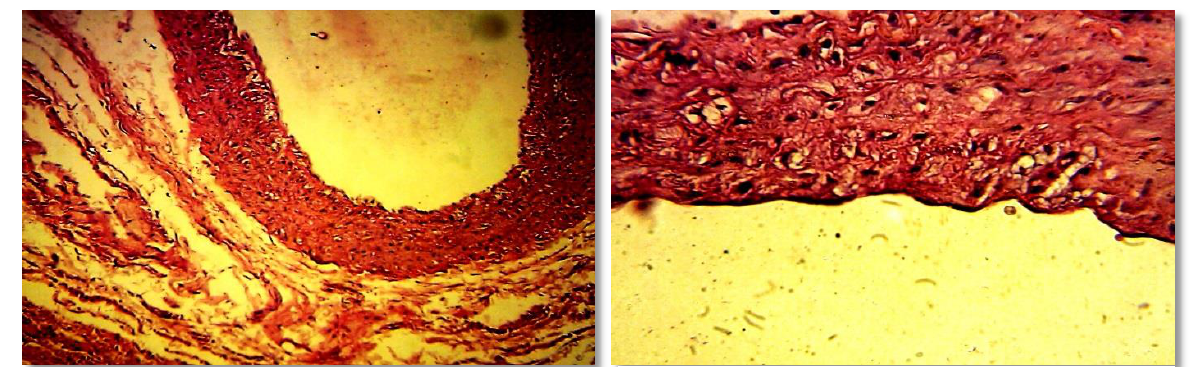
Figure,14: Section in the aorta of rabbit after 42 day of treatment with methionine over load and pometon (group T2). Note: no clear lesions (H &E stain 40X).